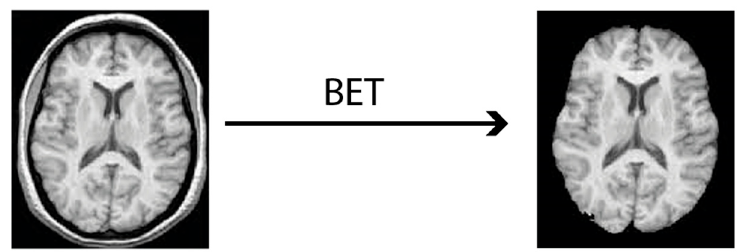
Figure 2. Skull stripping process using the Brain Extraction Tool